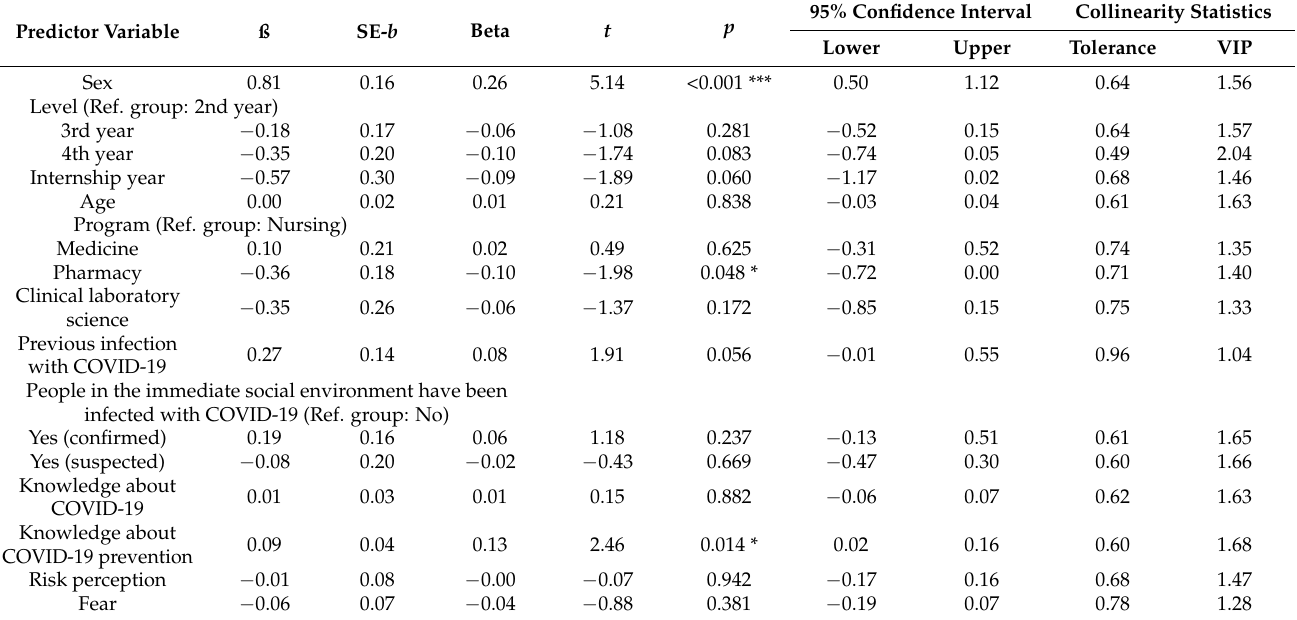
Table 2. Results of the multiple regression analysis on the students’ face mask use knowledge (n =